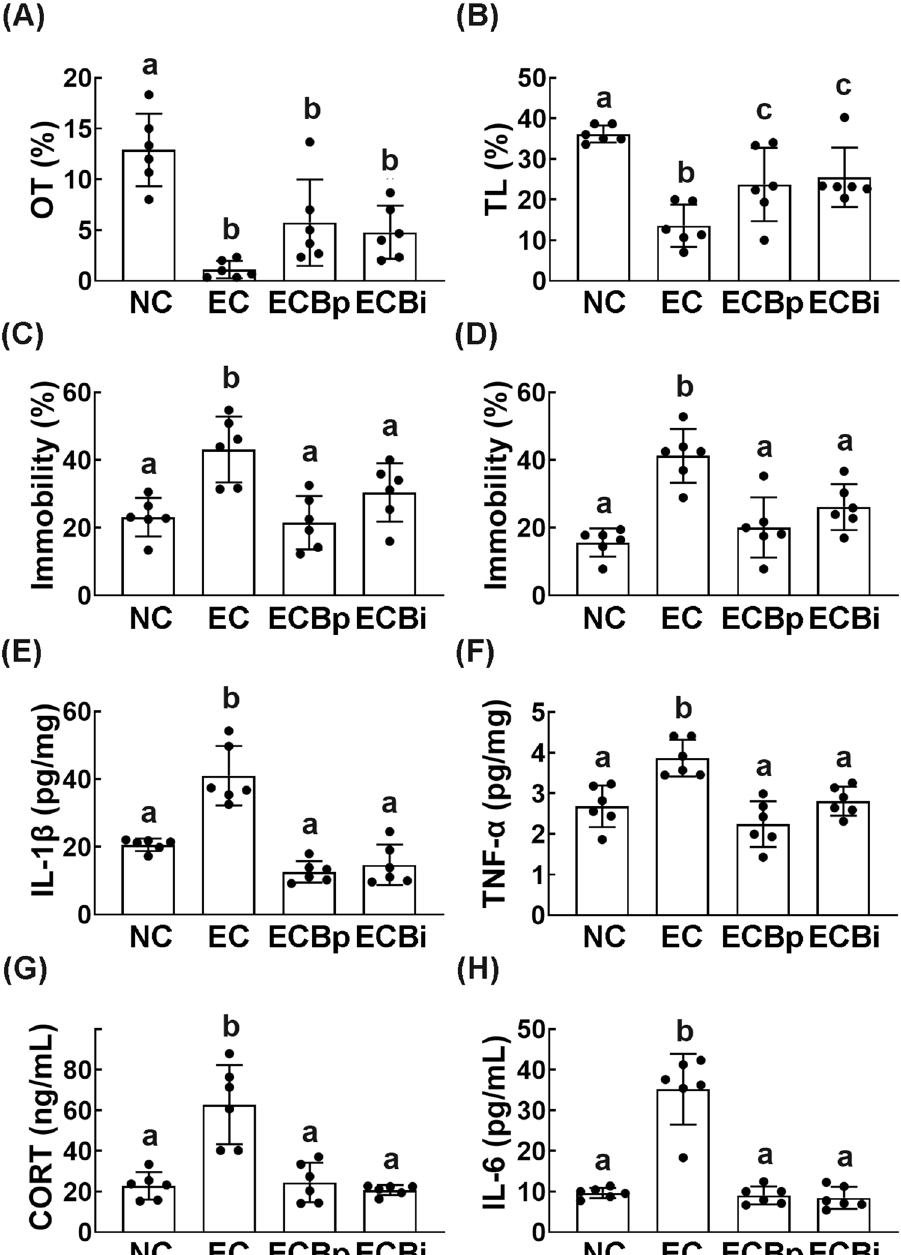
Figure 3. Orally gavage or intraperitoneal injection of buspirone alleviated Escherichia coli (EC)-induced anxiety/depression in mice. Effects on EC-induced anxiety/depression-like behaviors in EPM ( A , OT), LDT ( B , TL), TST ( C ), and FST ( D ). Effects on IL-1β ( E ) and TNF-α expression ( F ) in the hippocampus. Effect on corticosterone (CORT, G ) and IL-6 levels ( H ) in the blood. Buspirone was orally gavaged (EBPp, 5 mg/kg/day) or interaperitoneally injected (EBpi, 1 mg/kg/day) daily for 5 days from the next day after the final exposure to EC. EC and NC (normal control mice) was orally treated with vehicle (saline) instead of buspirone. Data values were indicated as mean ± SD (n = 6). Same letters are not significantly different ( p <